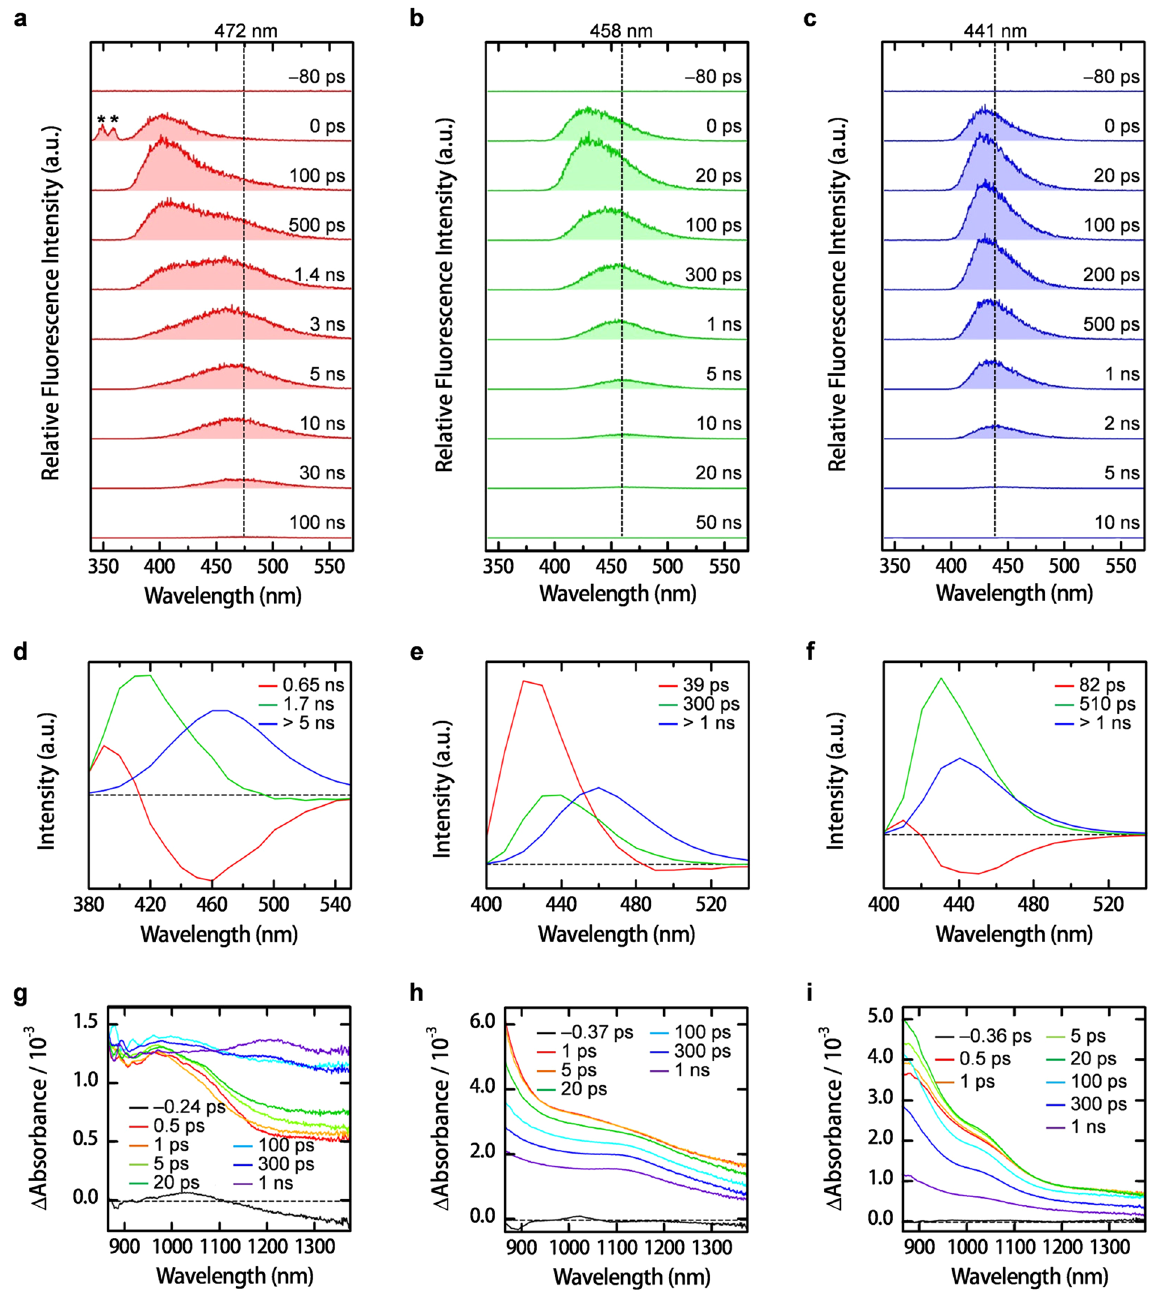
Figure 5. Excited-state dynamics of liquids 1 , 3 and 5 . Picosecond time-resolved fluorescence spectra of liquids 1 , 3 and 5 in ( a , b and c ) at time delays as denoted insets. Asterisks in ( a) (at 0 ps) denote the stray light signals caused by the excitation pulse. λ ex : 1 , 345 nm; 3 , 378 nm; 5 , 382 nm. Decay-associated spectra of 1 , 3 and 5 in ( d , e and f ) obtained by global least-squares fitting analysis with three exponential functions. Femtosecond time- resolved near-IR absorption spectra of liquids 1 , 3 and 5 in ( g , h and i ) for at time delays as denoted insets. λ ex : 1 , 345 nm; 3 and 5 , 380 nm. Pulse duration, ~100